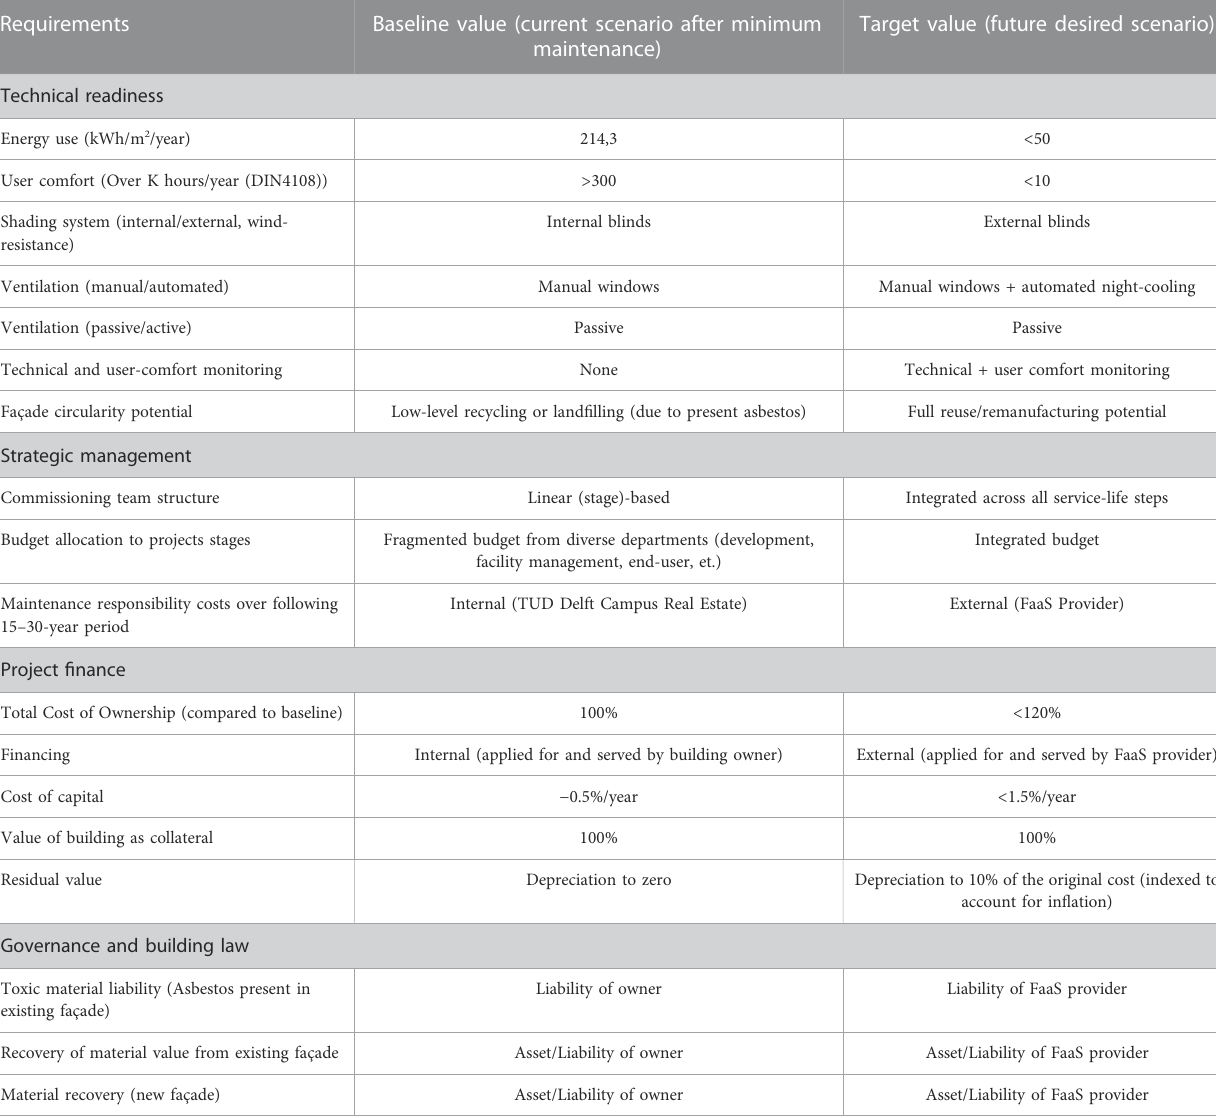
TABLE 2 List of functional and strategic requirements for the performance-based renovation of the CiTG East